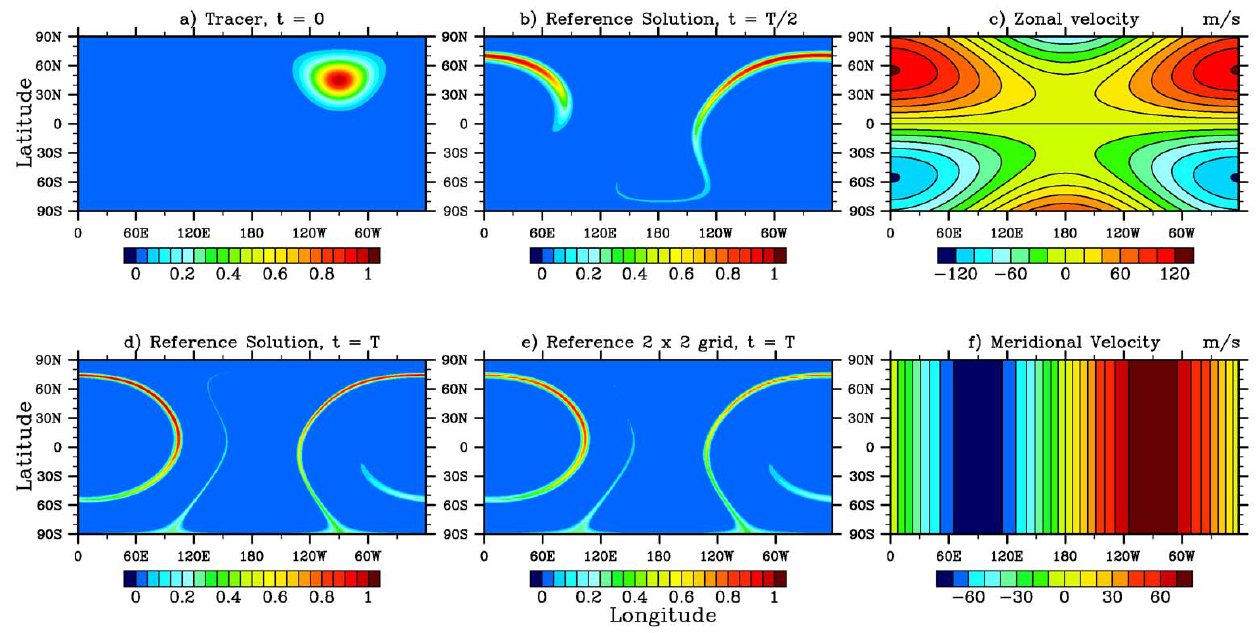
Fig. 3. As Fig. 1 but for test 3.